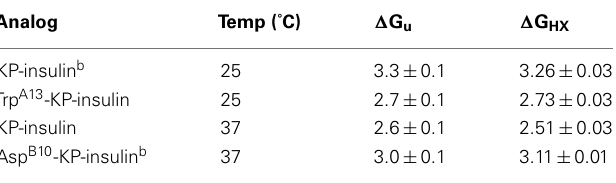
FIGURE 7 | Summary of protection factors (PF) and survey of hydrogen bonds. (A) Plot of residue-specific PFs in KP-insulin (vertical axis) versus sequence (horizontal axis). Color code: (red circles) sites of global exchange, (purple) subglobal exchange, and (green) local fluctuations. (B) Summary of amide hydrogen bonds (vertical segments) as inferred from NMR studies (top) and as predicted by crystal structures (bottom).The color code is as in (A) . Sites of global exchange in the A- and B-chains cluster near cystine A20–B19. Table 1 | Estimates of global thermodynamic stability a .